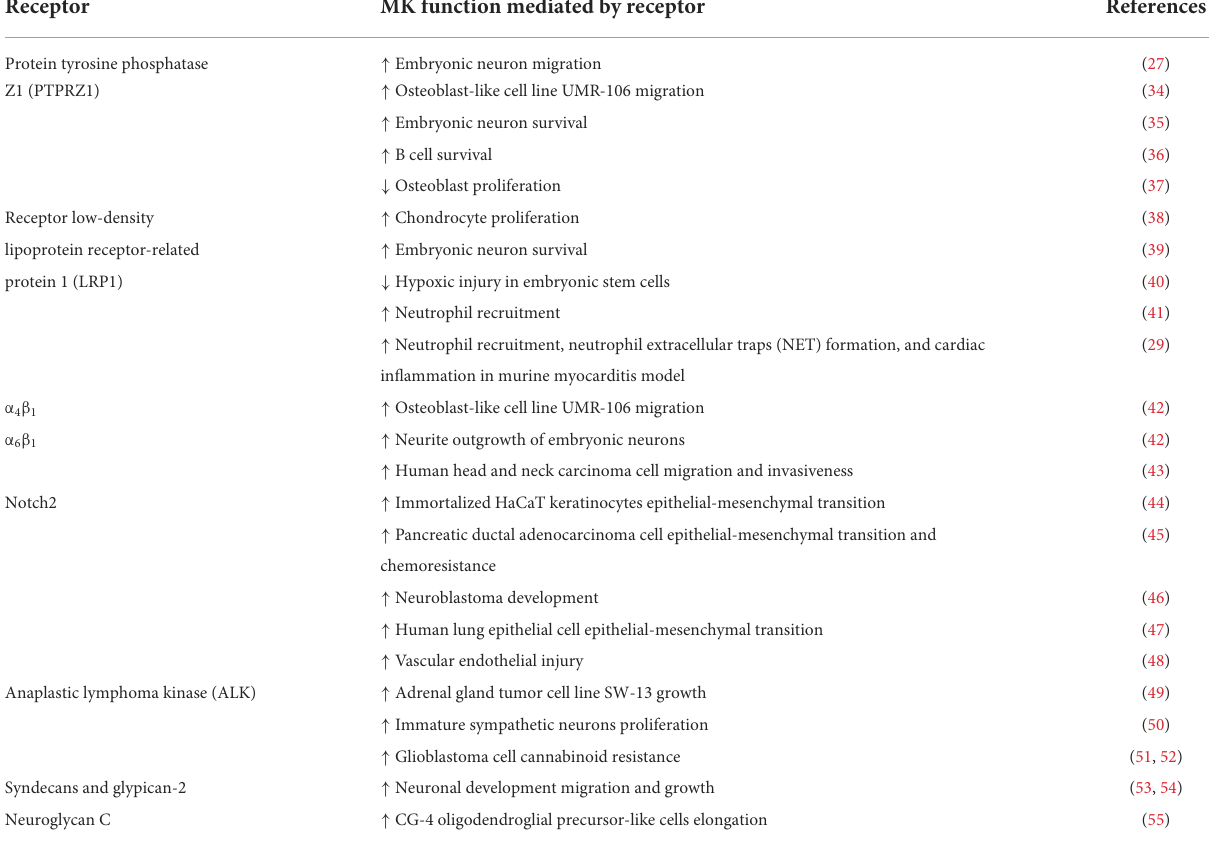
TABLE 1 Summary of MK receptors and their roles in MK functions. MK function mediated by